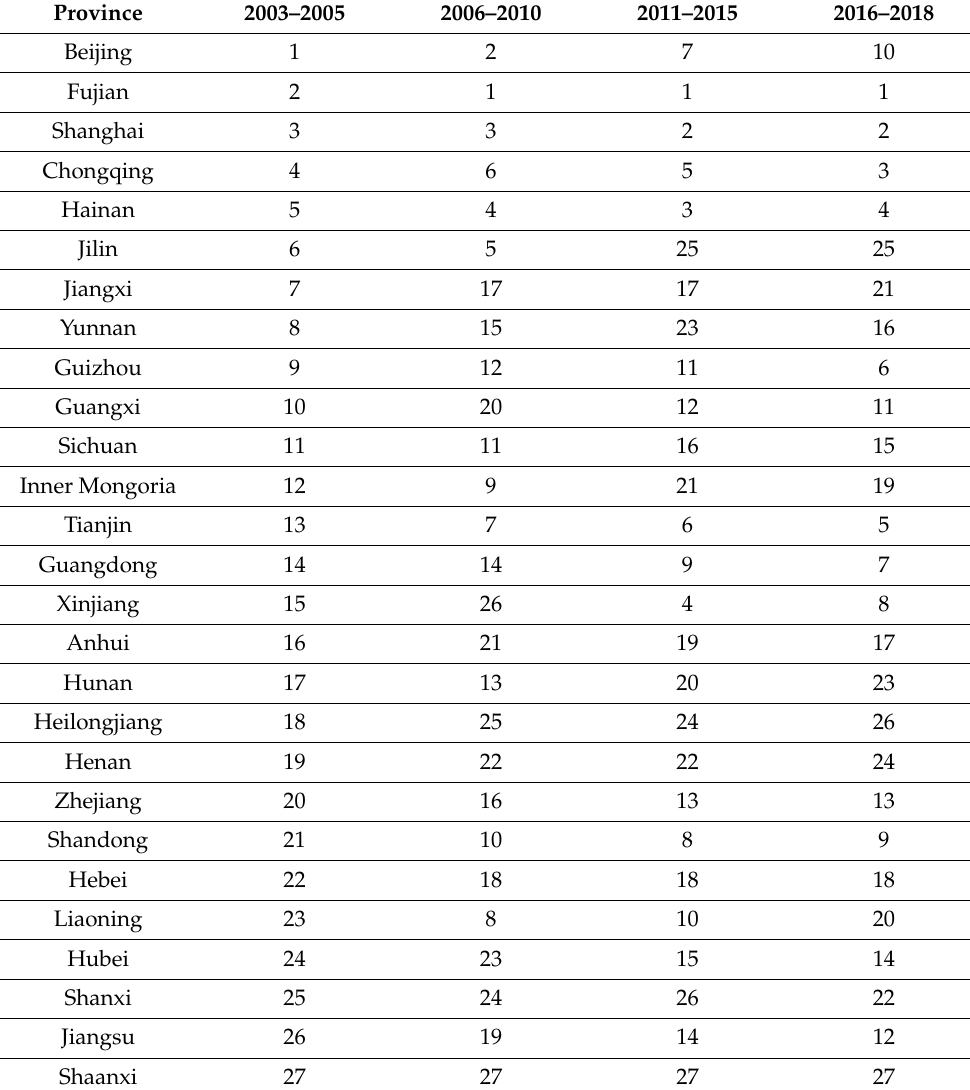
Table 3. Dynamic changes in eco-efficiency